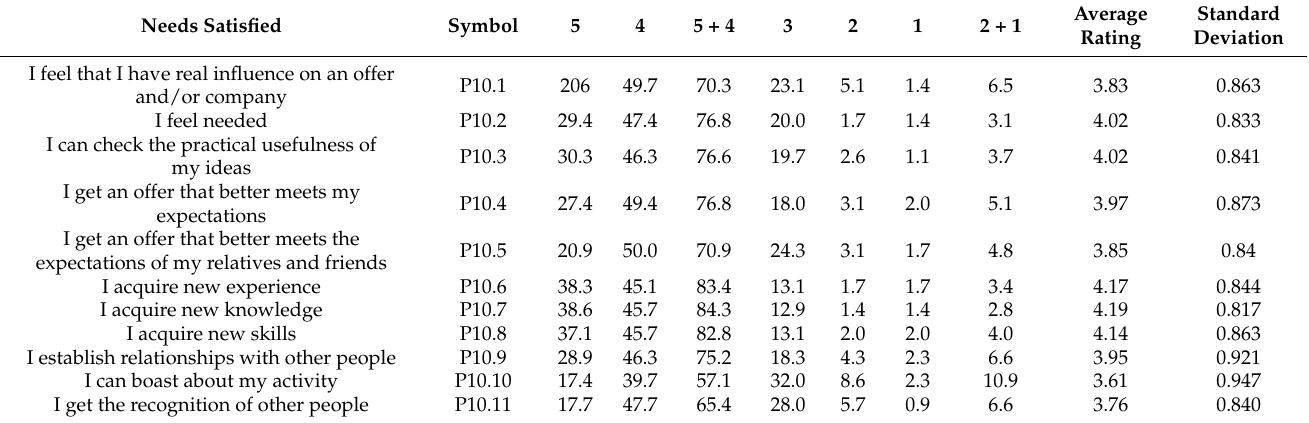
Table 1. Needs satisfied due to cooperation with offerors according to